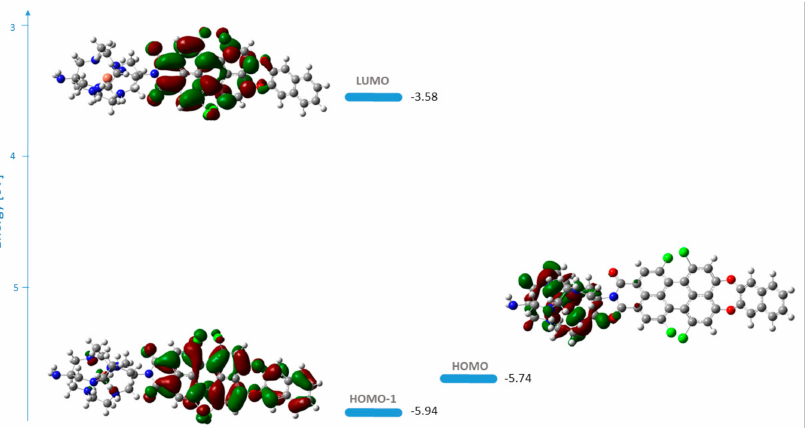
Figure 9. Energies and shape representation of HOMO − 1, HOMO, and LUMO in the excited state (S 1 ) of the complex of 1c with Cu 2+ ions in methanol from the TDB3LYP/6-31G(d,p) computations. Fluorescence enhancement will only take place if the sarcophagine orbitals in the bound state lie lower than the fluorophore orbitals and the reductive PET process cannot occur. In the Cu 2+ complex of 1c , the intense transition localized on the fluorophore corresponds to excitation from the HOMO − 1 → LUMO transition (Figure 9). HOMO